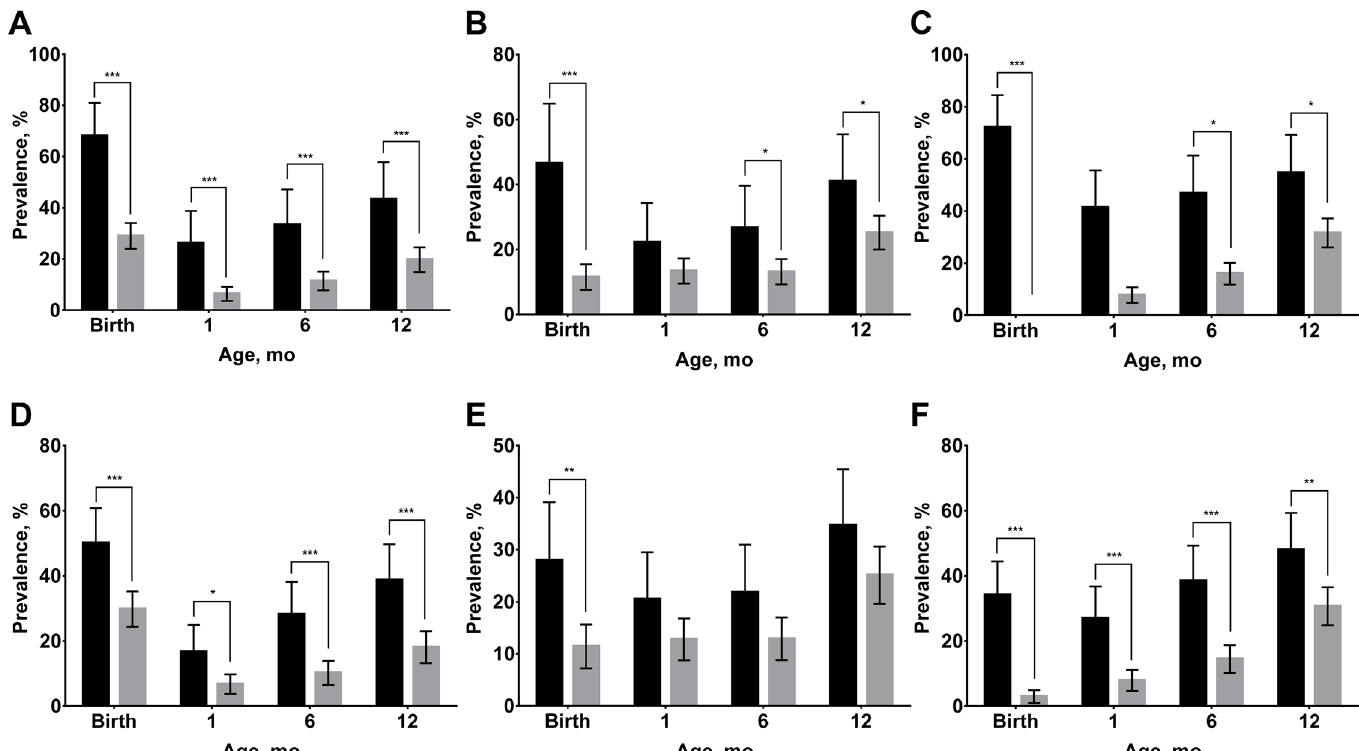
Fig 2. Stunting, wasting, and underweight from birth to 12 months of age by birthweight (A, stunting; B, wasting; C, underweight) and size for gestational age (D, stunting; E, wasting; F, underweight). Values are prevalence and 95% confidence intervals, n = 357. In A, B, and C, black bars indicate low birthweight; gray bars indicate non-low birthweight. In D, E, and F, black bars indicate small-for-gestational age; gray bars indicate non-small-for- gestational age. Stunting, wasting, and underweight were defined as height-for-age Z score < -2.0, weight-for-height Z score < -2.0 and weight-for-age Z score < -2.0, respectively. Low birthweight was defined as birthweight < 2.5kg. Small-for-gestational age was defined as birthweight < 10 th percentile for gestational age. * P < 0.05, ** P < 0.01, *** P < 0.001 different from low birthweight or small-for-gestational age